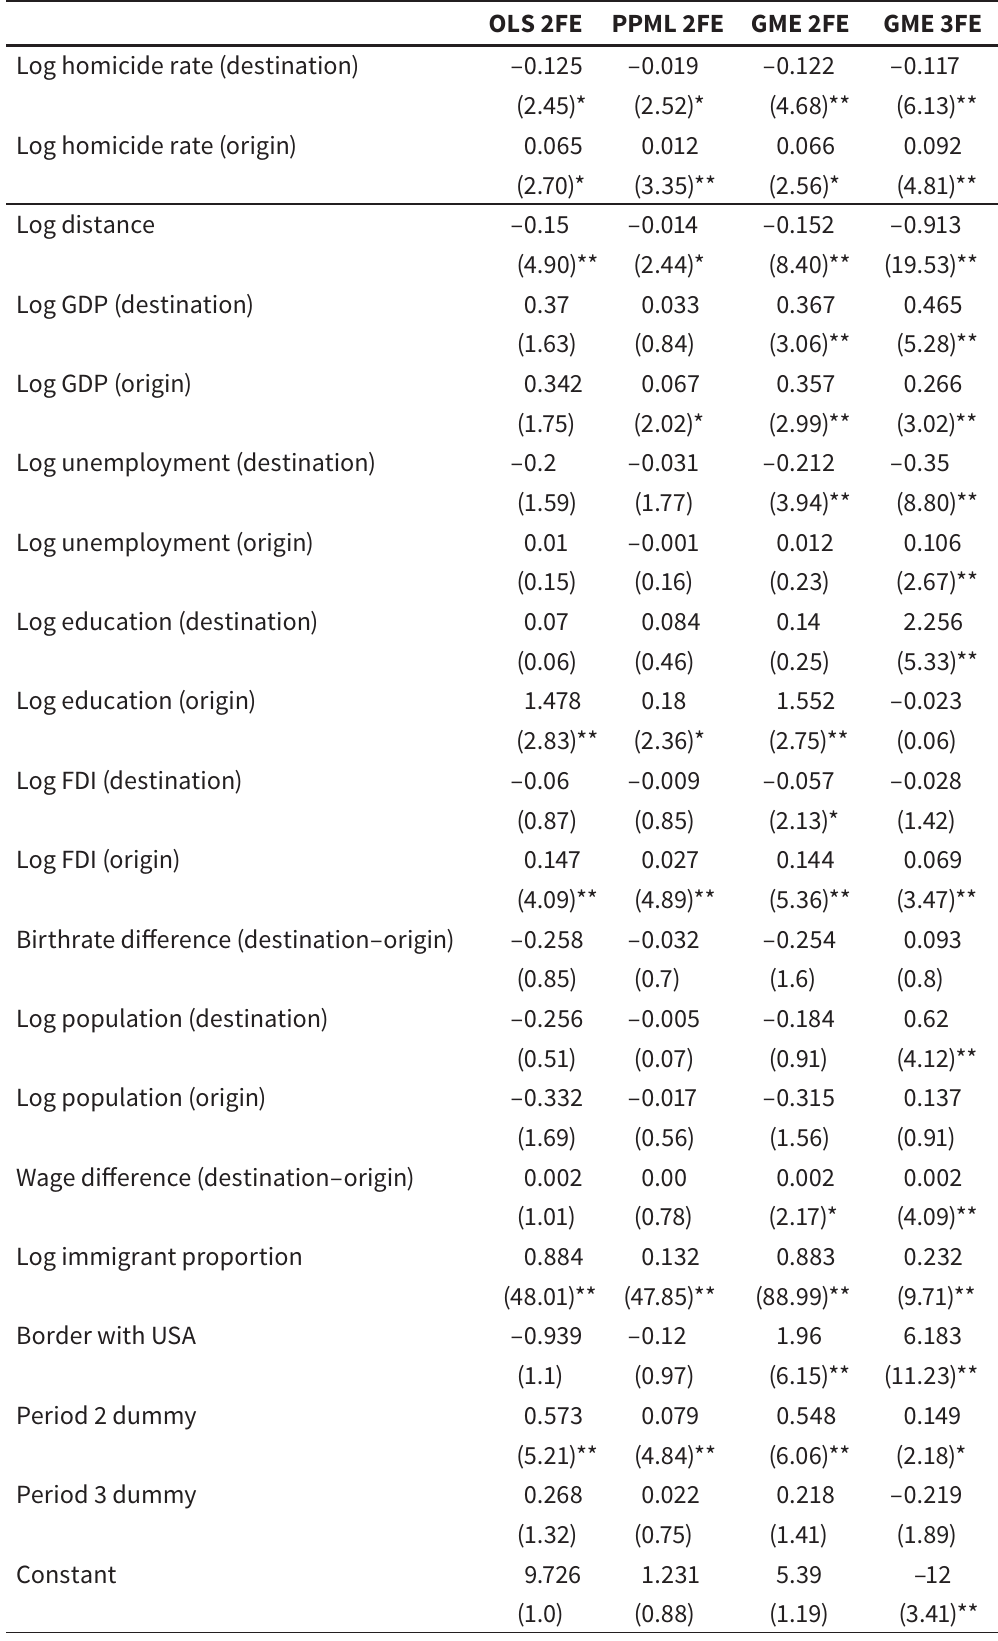
Gravity equation estimates (OLS, PPML, and